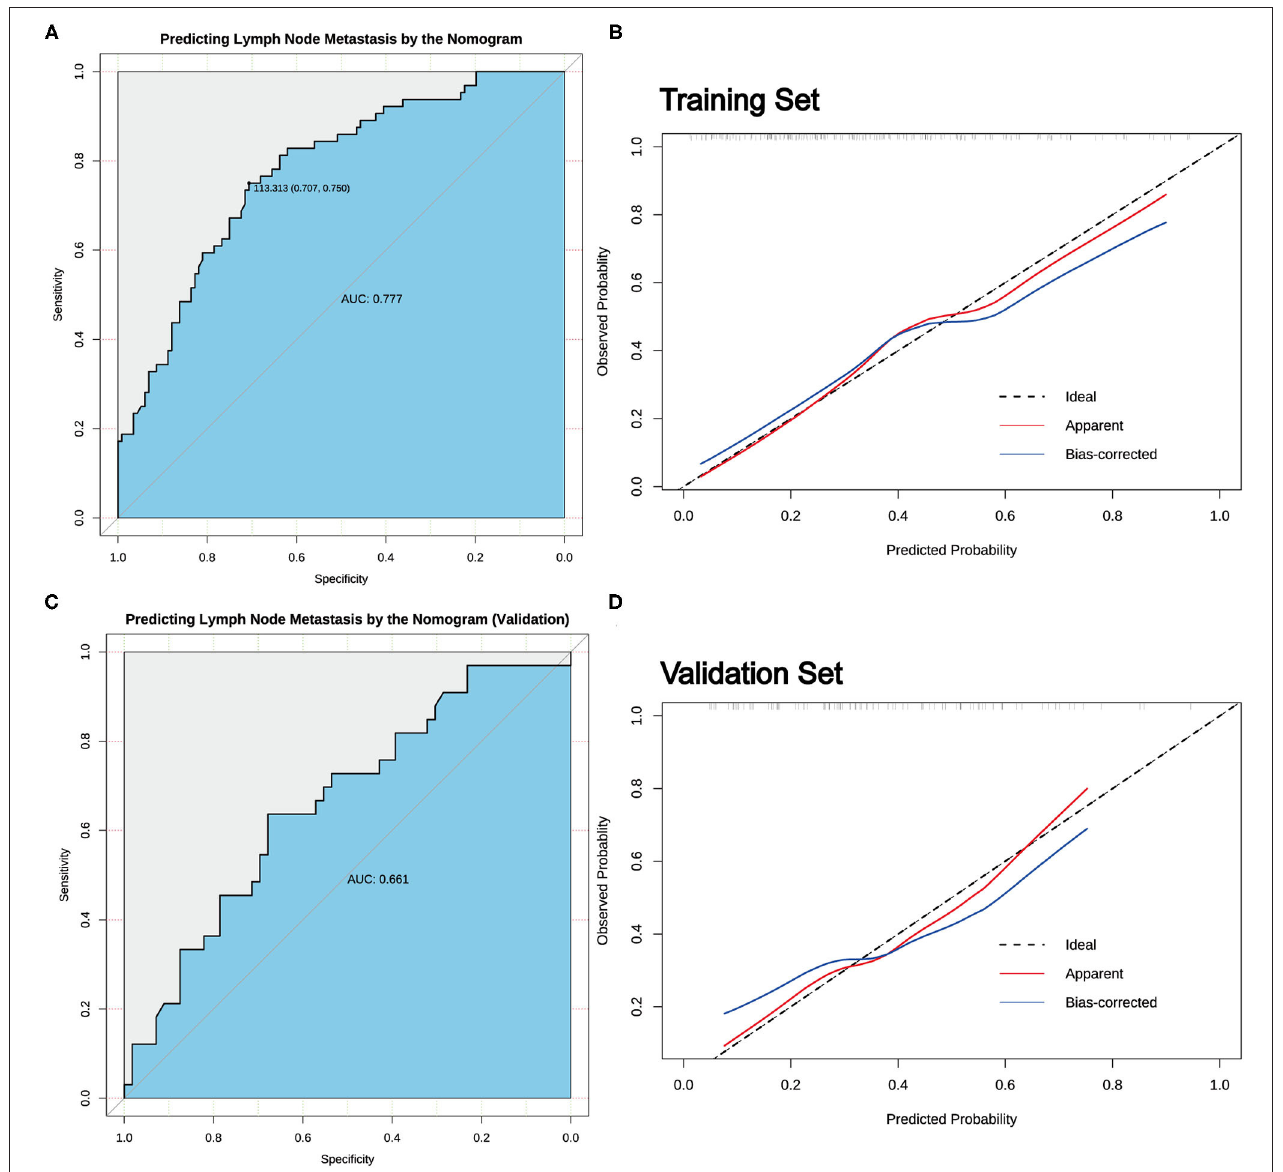
FIGURE 4 | The predictive value of the nomogram. (A) The receiver operating characteristic (ROC) curve for predicting CLNM in cN0 unilateral PTMC patients in the training set. (B) Calibration curves of the nomogram for predicting CLNM in cN0 unilateral PTMC patients in the training set. (C) The ROC curve for predicting CLNM in cN0 unilateral PTMC patients in the validation set. (D) Calibration curves of the nomogram for predicting CLNM in cN0 unilateral PTMC patients of the validation